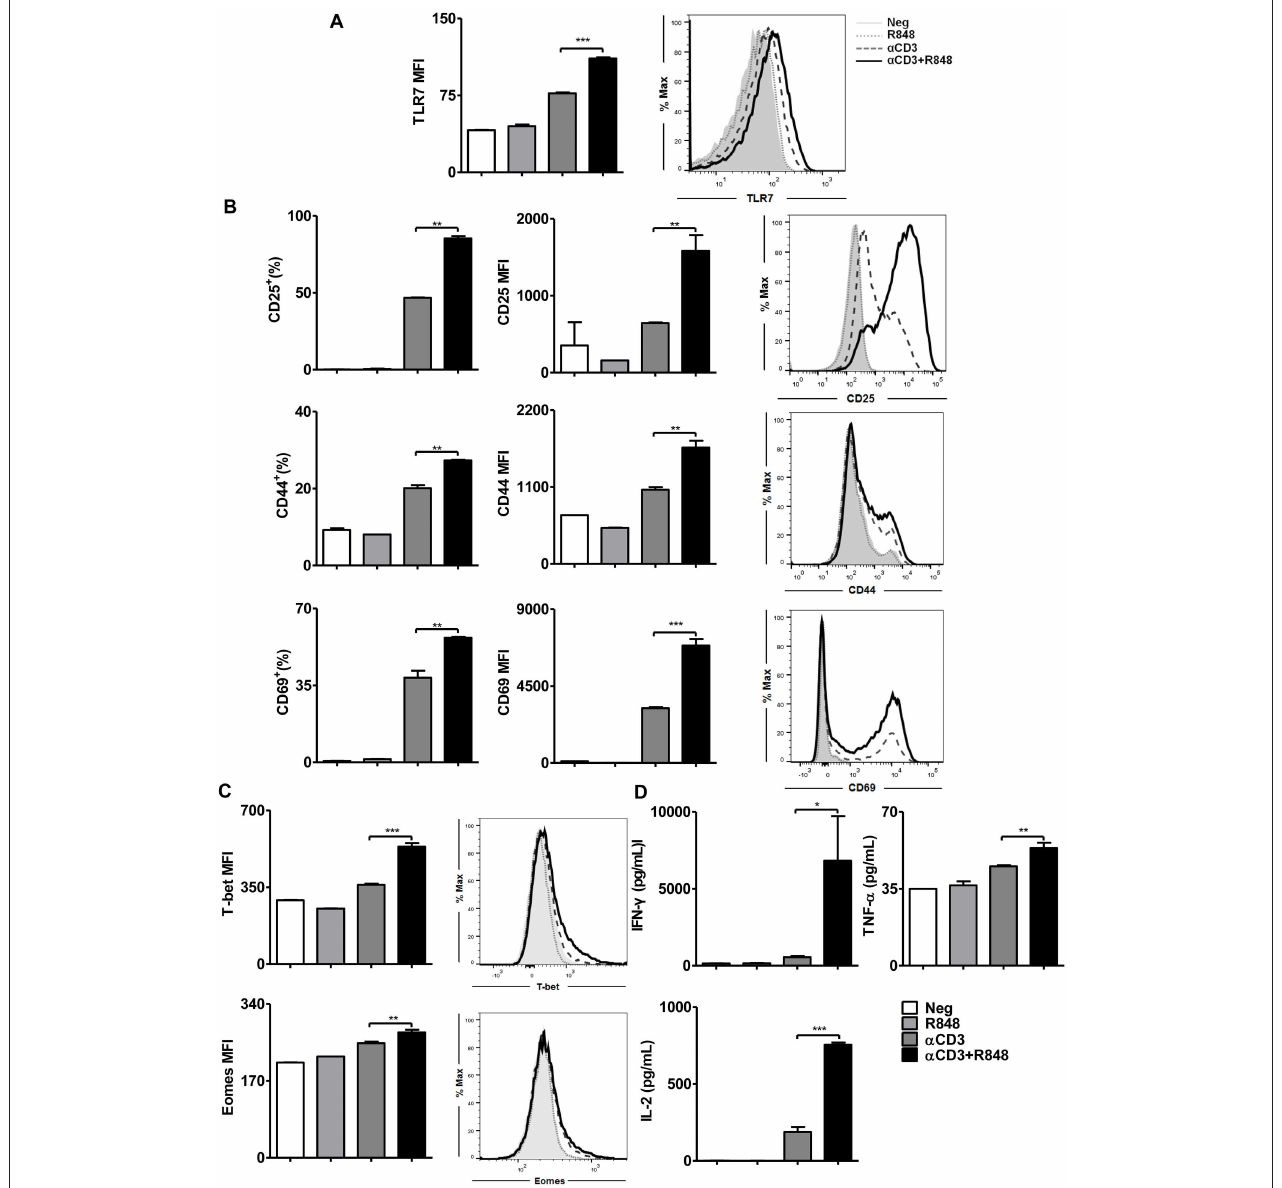
FIGURE 1 | TLR7 ligands enhance CD8 + T cell activation and cytokine production. Purified CD8 + T cells were stimulated in plates with bound α CD3 antibody (5 µ g/mL) alone or with R848 (10 µ g/mL) for 24h. TLR7 (A) , CD25, CD44, and CD69 (B) , and T-bet and Eomes (C) expression in CD8 + T cells were measured by flow cytometry. (D) Cytokines production including IFN- γ , TNF- α , and IL-2 was measured by specific ELISAs. Data are representative of three independent experiments. N = 3 wells per condition. All data are presented as mean ± SD. The statistical relevance was determined by One-way ANOVA: * p < 0.05; ** p < 0.01; *** p <